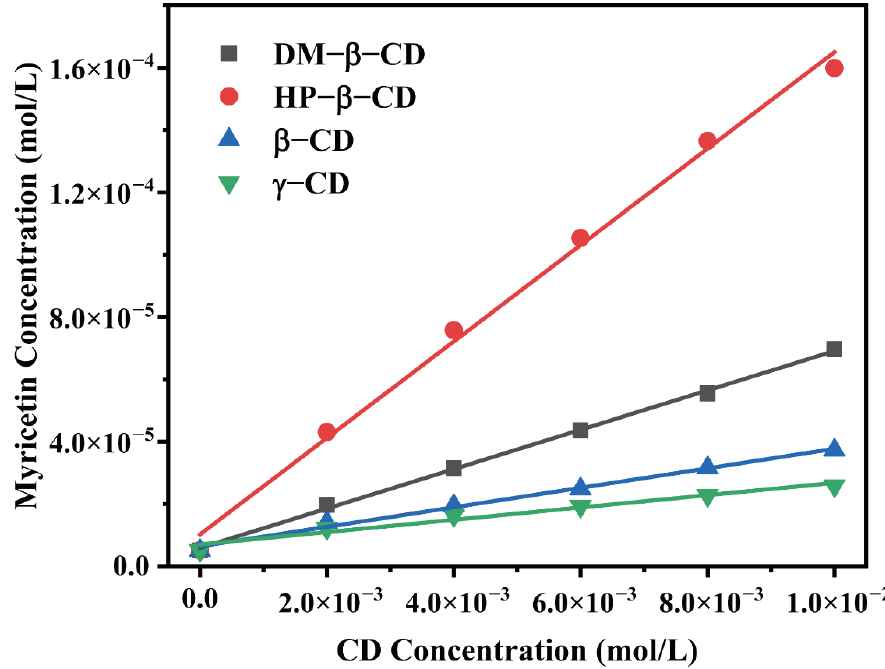
Figure 2. Phase solubility diagrams of myricetin in aqueous solution with the presence of various CDs.